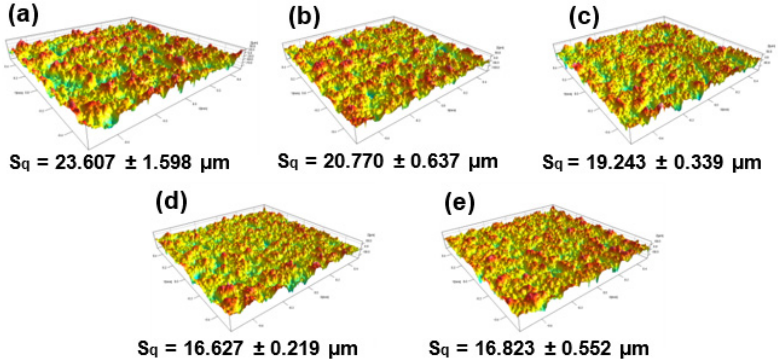
Figure 5. Surface roughness of CPED coatings with different SiC additions: ( a ) S0; ( b ) S5; ( c ) S10; ( d ) S15; ( e ) S20. ( d ) S15; ( e )